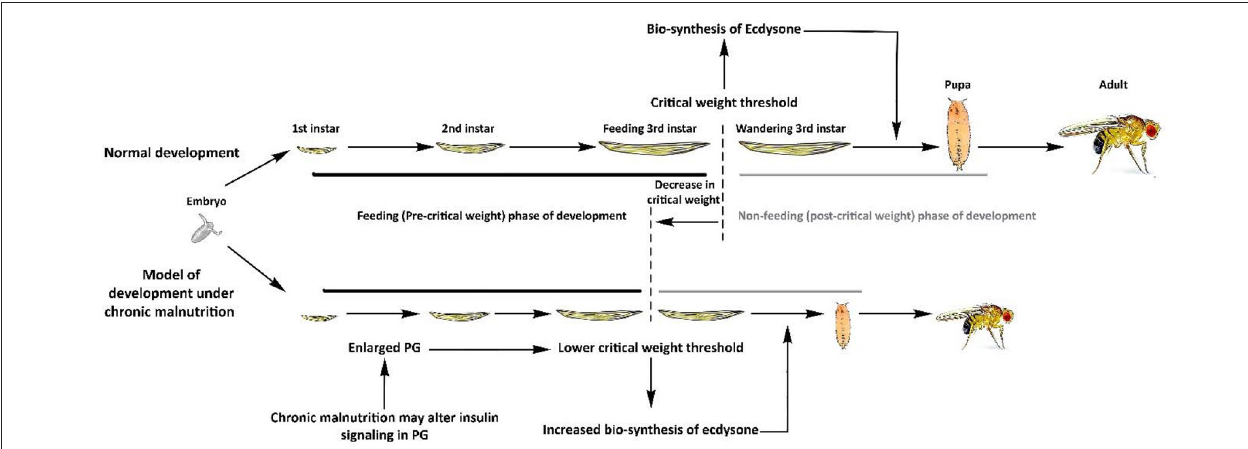
FIGURE 2 | Proposed model for the development of fly populations selected under chronic malnutrition. Under normal rearing conditions, larvae feed during the pre-critical phase to achieve critical weight, which results in release of an ecdysone pulse. This hormonal shift ceases larval feeding and drives the larval-to-pupal transition. Under chronic malnutrition, the prothoracic gland (PG) might become nutritionally desensitized through elevated PI3K/Akt signaling, which consequently enlarges its size. This lowers the critical weight threshold and results in increased synthesis of ecdysone, driving an early larval-to pupal transition. This shift in the critical weight threshold results in accelerated development time and lower body size and